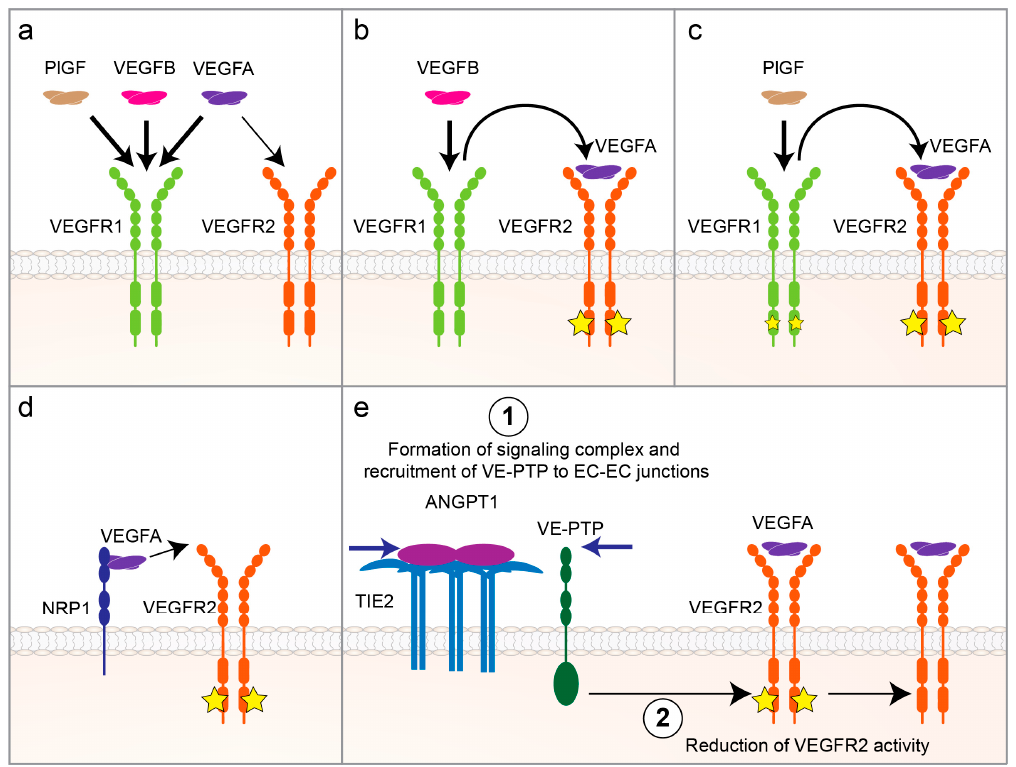
Figure 2. Regulation of vascular endothelial growth factor A (VEGFA) / vascular endothelial growth factor receptor 2 (VEGFR2) signaling. ( a ) Placental growth factor (PlGF), VEGFB and VEGFA compete for binding to VEGFR1. VEGFA has ten times higher binding a ffi nity to VEGFR1 than to VEGFR2 (reviewed in Reference [71]). ( b ) Binding of VEGFB to VEGFR1 displaces VEGFA and increases its bioavailability for binding to VEGFR2, which then induces angiogenic signaling via VEGFR2 activation. ( c ) Binding of PlGF to VEGFR1 increases angiogenesis both by displacing VEGFA and making it available for VEGFR2-binding and by activating PlGF’s own, albeit weaker, angiogenic signaling via VEGFR1 [77]. ( d ) Neuropilin-1 (NRP1) binds to VEGFA and presents it to VEGFR2, which enhances VEGFA / VEGFR2 signaling (reviewed in Reference [78]). ( e ) Binding of Angiopoietin 1 (ANGPT1) to its receptor TIE2 on endothelial cell (EC) surface activates signaling complex formation and recruits vascular endothelial protein tyrosine phosphatase (VE-PTP) to EC-EC junctions, which reduces VEGFR2 activity (reviewed in Reference [ 79 ] ).